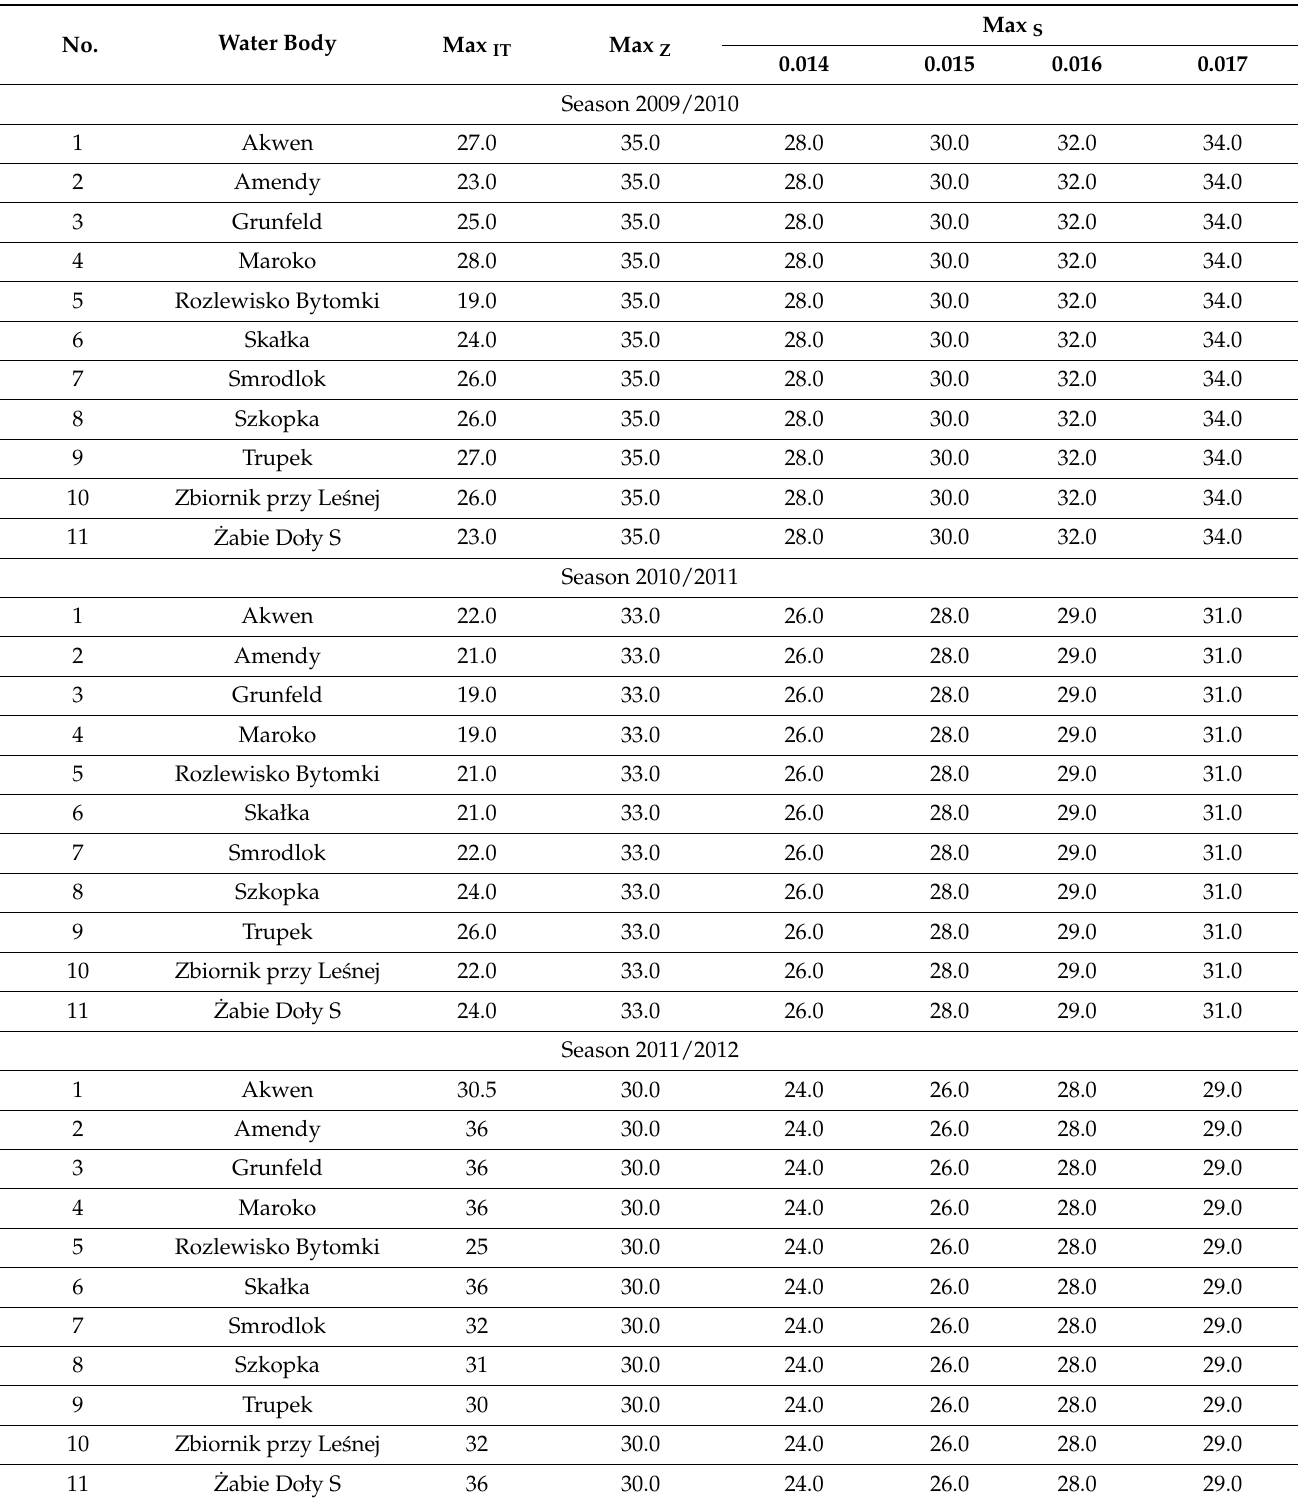
Table 3. Maximum thickness of ice cover on water bodies in Katowice Upland in 2009/2010– 2011/2012 winter